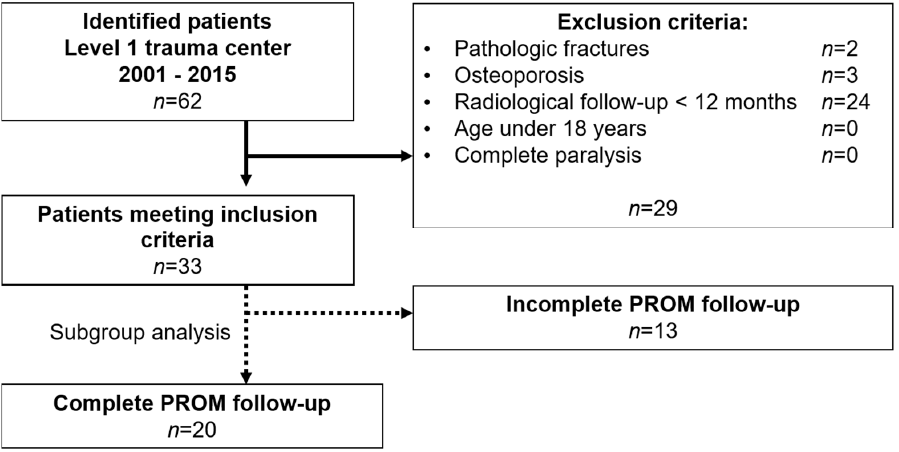
Figure 2. Flowchart of patient enrollment. Sixty-two patients with subaxial cervical fractures were identified between 2001 and 2015. After applying the exclusion criteria, 33 patients were eligible to be included in the study cohort. Twenty patients completed the PROM follow-up, at least 24 months after surgery.